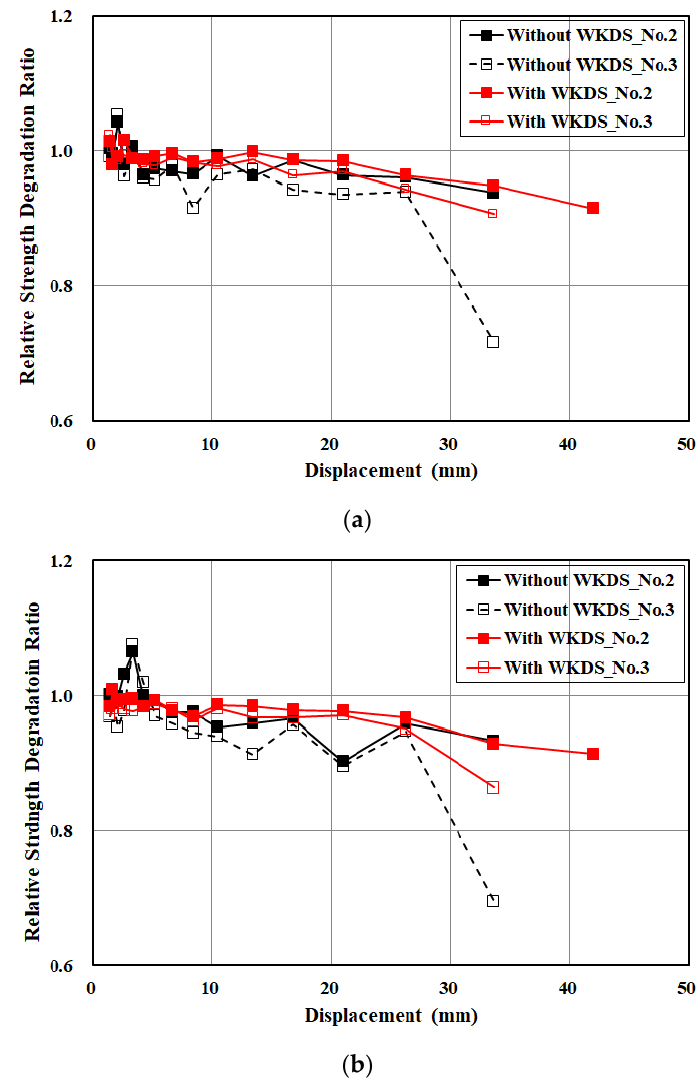
Figure 15. Strength degradation ratios in repeated loadings. ( a ) Loading in positive direction, ( b ) Loading in negative direction.